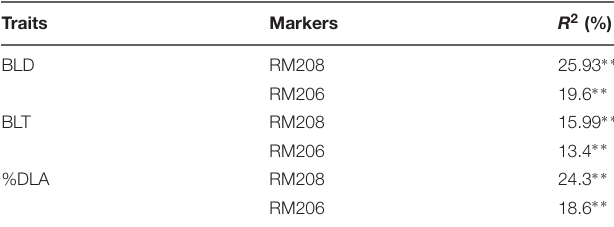
TABLE 4 | Association between the marker and trait in the BC 2 F 2 population analysed by regression analysis.